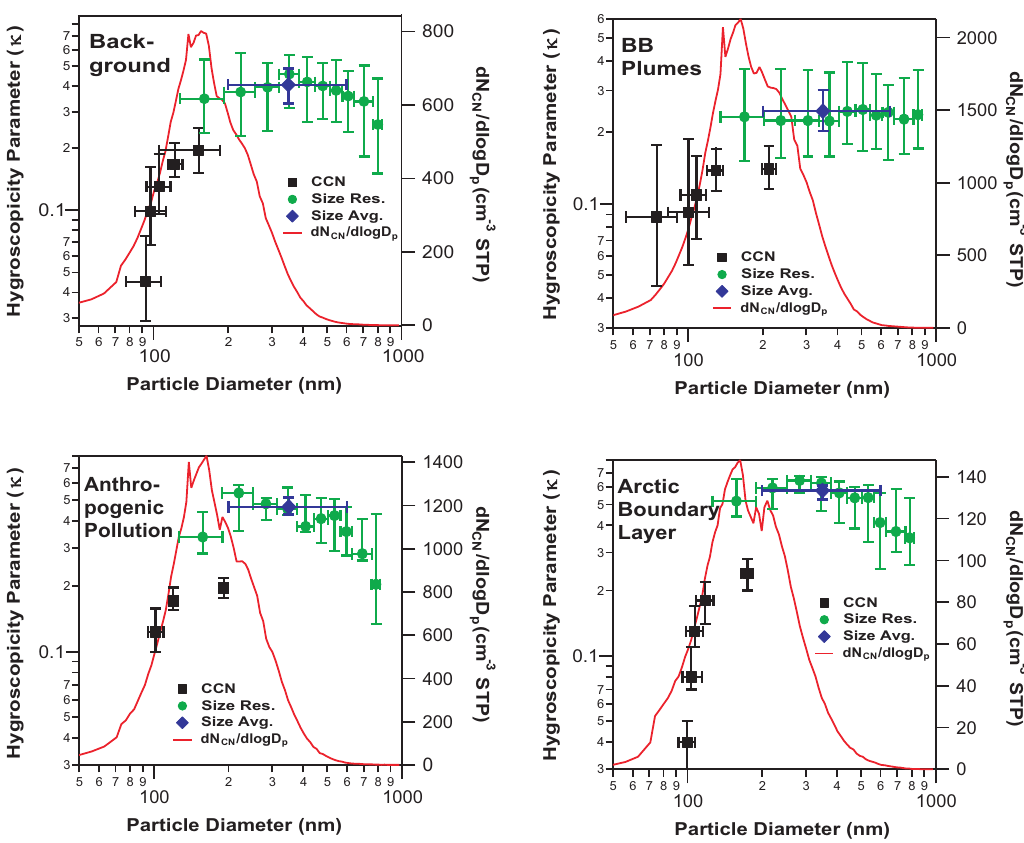
Fig. 6. Inferred values of the hygroscopicity parameter, κ , obtained from the measured CCN concentrations and size distributions and plotted against the critical activation diameter, D p , c (squares). Also shown are κ values calculated for particle compositions obtained from size- resolved (circles) and size-averaged (diamonds) C-ToF-AMS measurements. Markers denote the median values for each air mass type, while error bars denote the interquartile range. The solid line shows the average particle size distribution from Figure 2 (on linear scale).